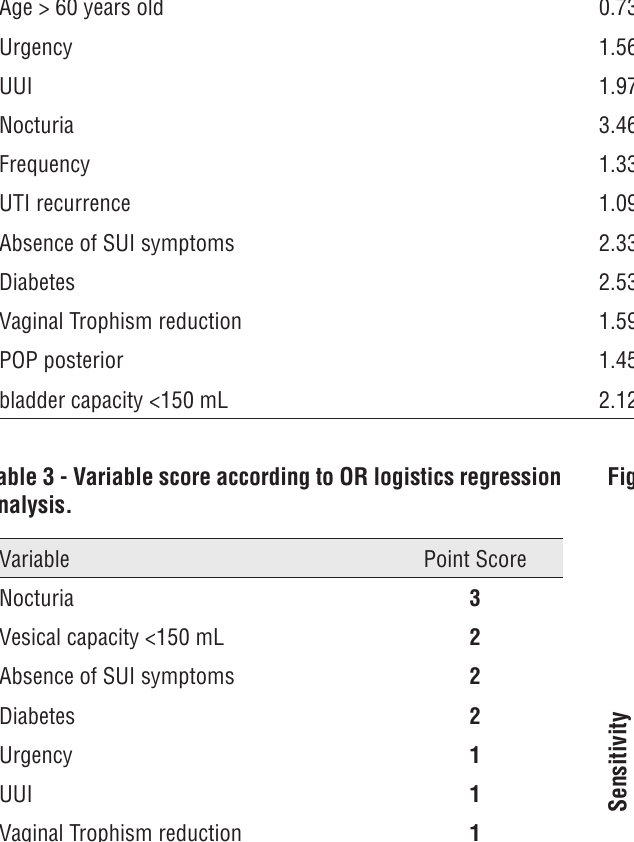
Table 4 - OAB Score and IDC probability in the urodynamic study.